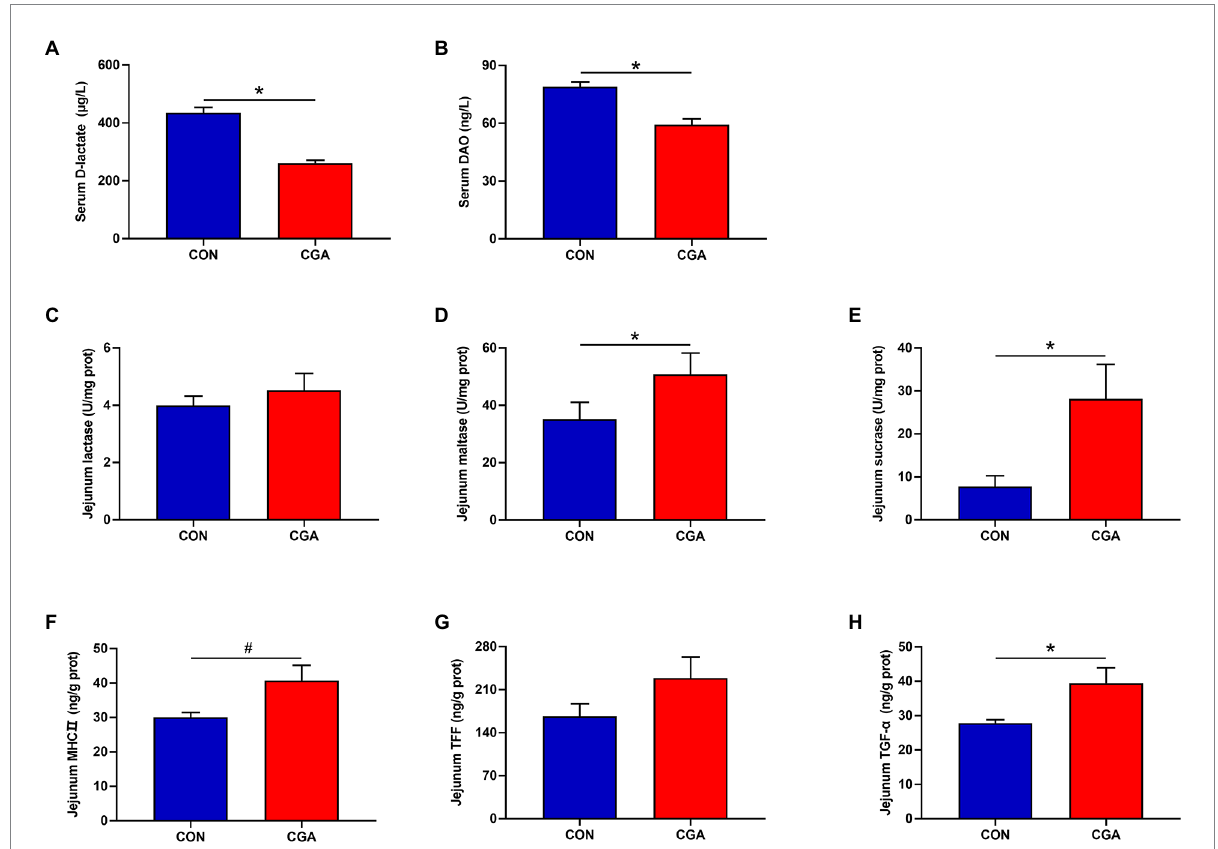
FIGURE 2 Effects of CGA on the maturity and integrity of small intestine in weaned rabbits. (A) serum D-lactate; (B) serum diamine oxidase (DAO); (C) jejunal lactase; (D) jejunal maltase; (E) jejunal sucrase; (F) jejunal major histocompatibility complex II (MHCII); (G) jejunal trefoil factor family (TFF); (H) jejunal transforming growth factor- α (TGF- α ). CON, rabbits fed a basal diet; CGA, rabbits fed the basal diet supplemented with 800 mg/kg chlorogenic acid. Results are presented as mean and SEM ( n = 8). Significant difference was recorded by 0.01 < p < 0.05*. # Means a tendency to difference (0.05 < p <